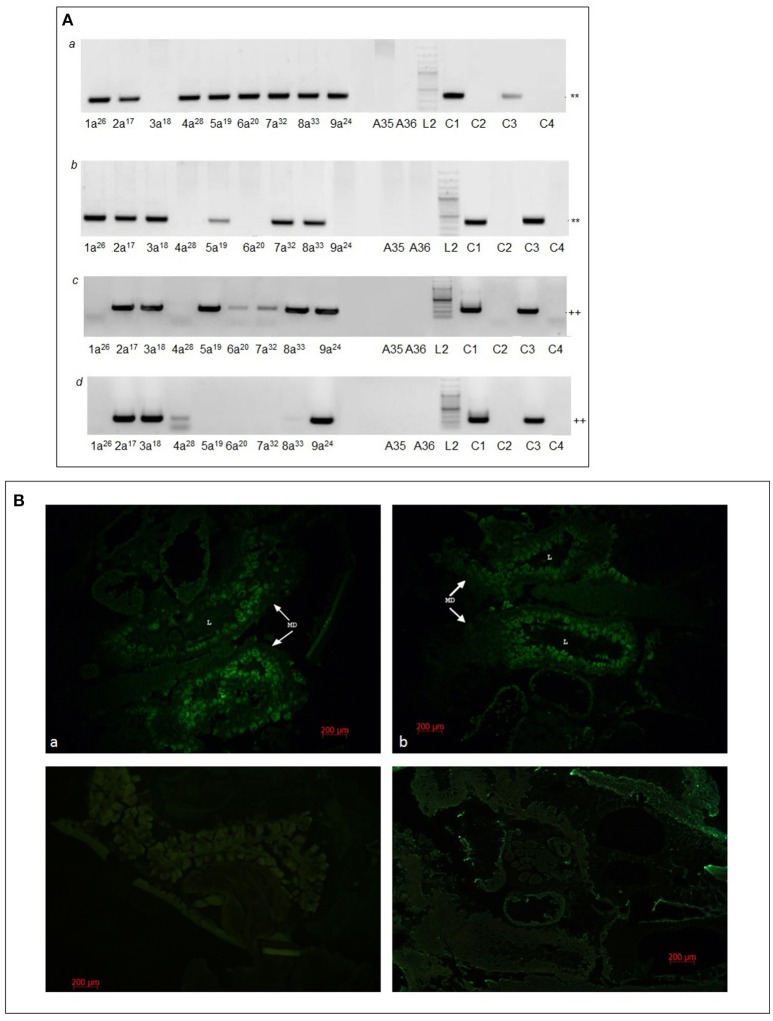
MHV68 detection in lung and spleen samples from mice infested with F1i adults and in F1i female ticks. (A) Lung (a,c) and spleen (b,d) samples of mice infested with F1i adults examined by nested PCR (a,b) and RT-PCR (c,d). Lanes 1a26, 2a17, 3a18, 4a28, 5a19, 6a20, 7a32, 8a33, and 9a24 samples of mice infested with F1i adult ticks; A35, A36, samples of control mice infested with F1c adults. Lanes L2, C1–C4 as for Figure 1A. ** Indicates MHV68 ORF50 gene nested PCR product of 382 base pairs; ++ indicates MHV68 M3 gene nested RT-PCR product of 241 base pairs. (B) Semi-thin sections of frozen whole body of F1i females fed for 4 days. (a,b) F1i tick from mouse 3a18 and 5a19 stained with anti-MHV68 rabbit polyclonal serum; (c) uninfected tick (F6 generation of breeding) stained with anti-MHV68 rabbit polyclonal serum; (d) F1i tick from mouse 3a18 stained with rabbit polyclonal serum against PB1-F2 protein of influenza virus A (H1N1) (negative control). MD, cells of midgut diverticula; L, lumen of midgut diverculum. Scale bar, 200 μm.